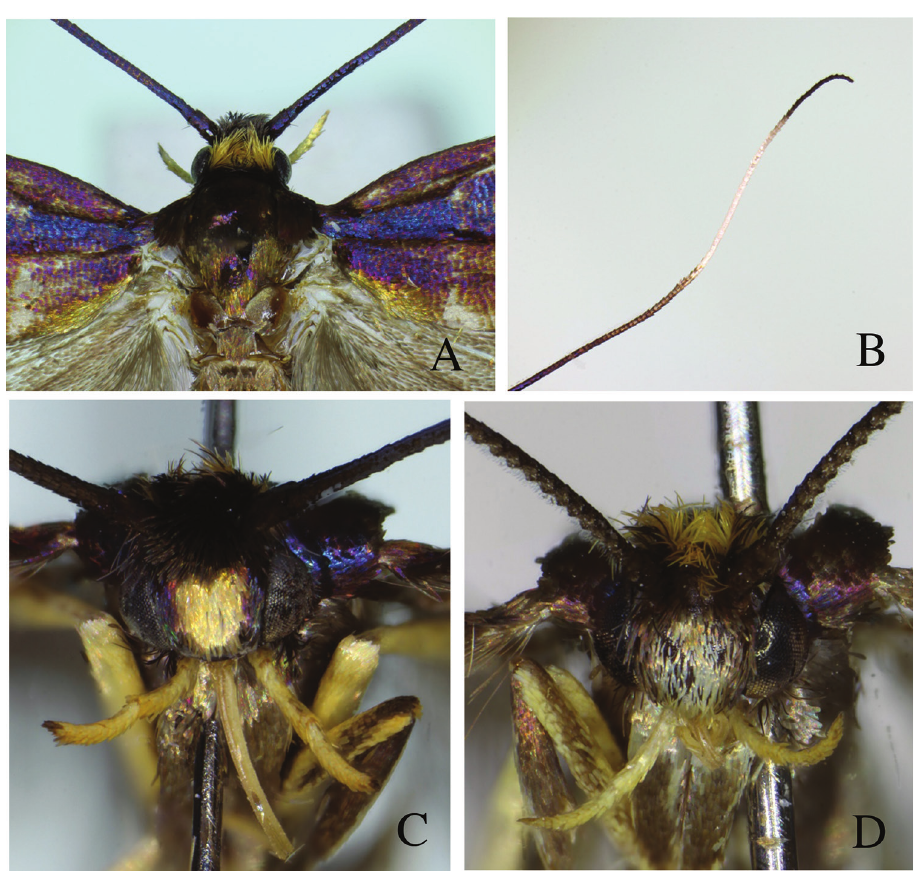
Figure 5. Head and thorax of Roeslerstammia tianpingshana sp. n. A Paratype female, dorsal view B Ditto , distal half of antenna C Ditto , head, frontal view D holotype, head, frontal